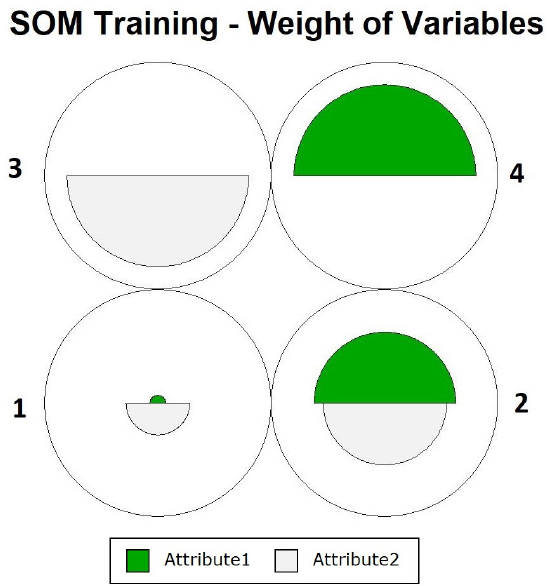
Figure 8. Variable distribution—synthetic database, level 2, neuron